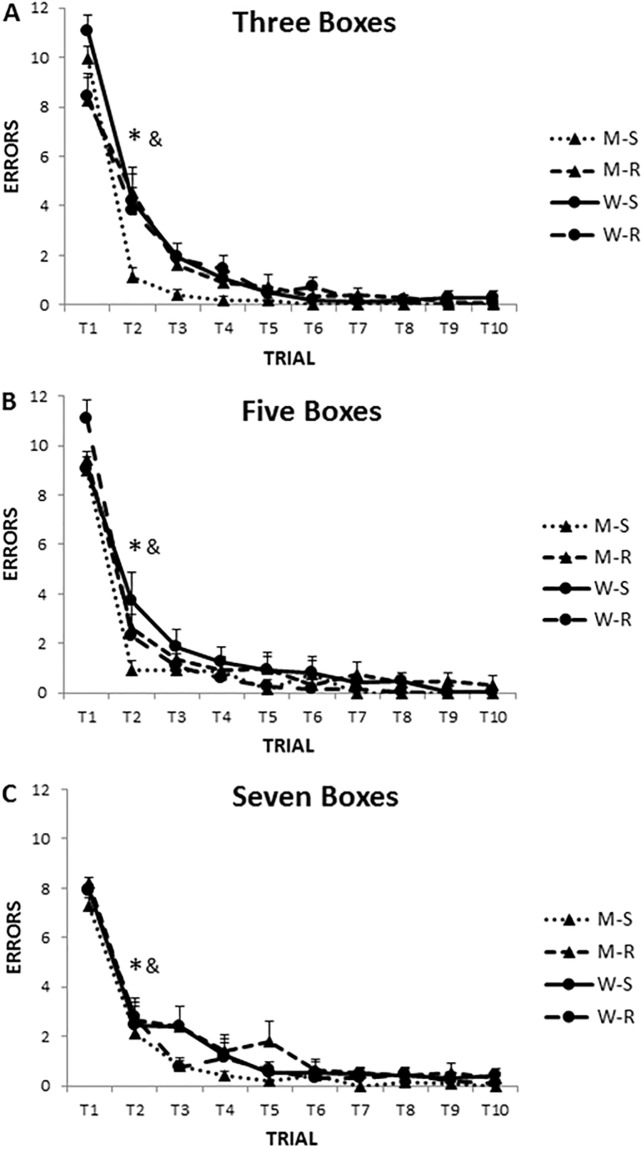
Number of errors in the WSBRT.A) Three boxes condition. B) Five boxes condition. C) Seven boxes condition. In the stable condition, men achieved the asymptotic level sooner than women searching for three and five positions. & gender differences; * decrease of number of errors (p<0,05). M-S (men stable), M-R (men rotated), W-S (women stable), W-R (women rotated). Mean±SEM.